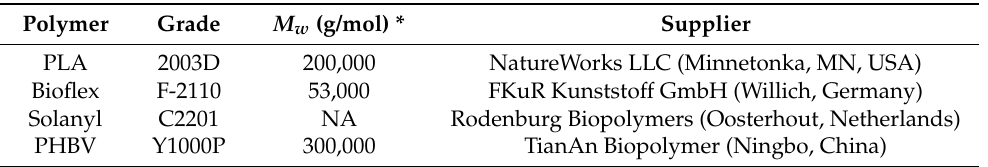
Table 1. List of Polymers used in this